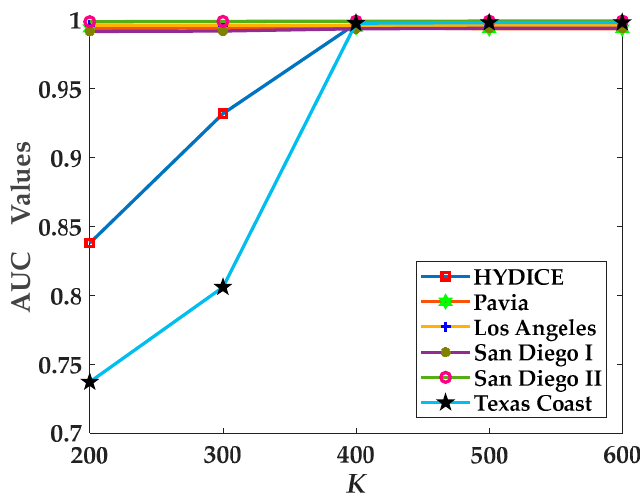
Figure 7. Effect of parameter K over AUC values on experimental datasets.